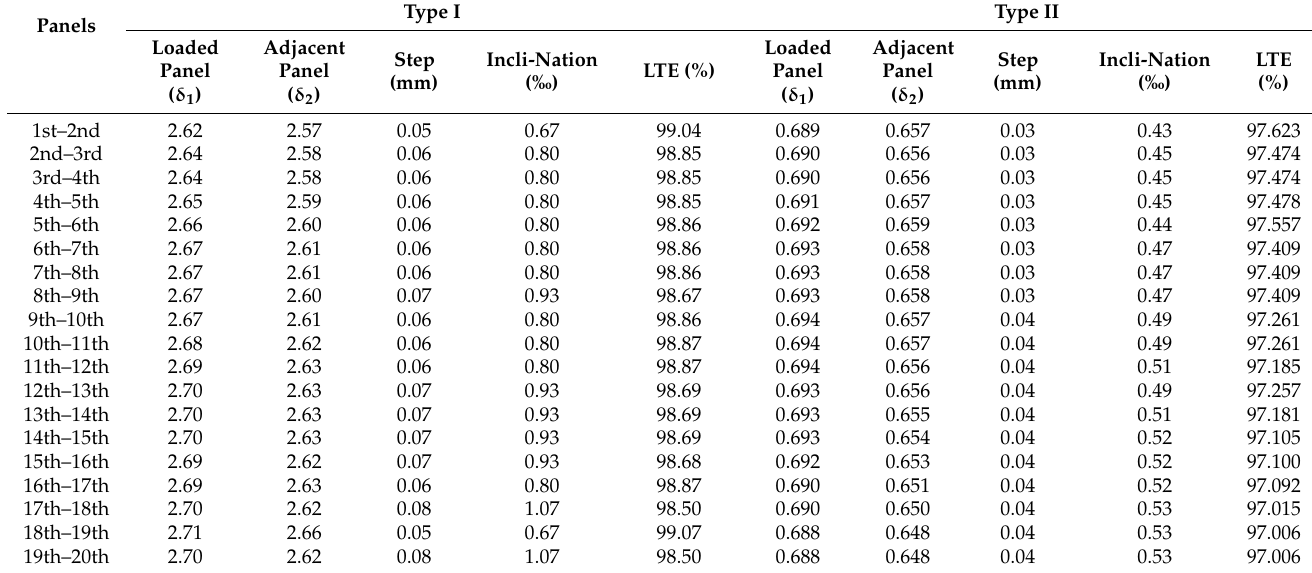
Table 4. Load Transfer Efficiency (LTE) of rail between loaded panels and adjacent panels.